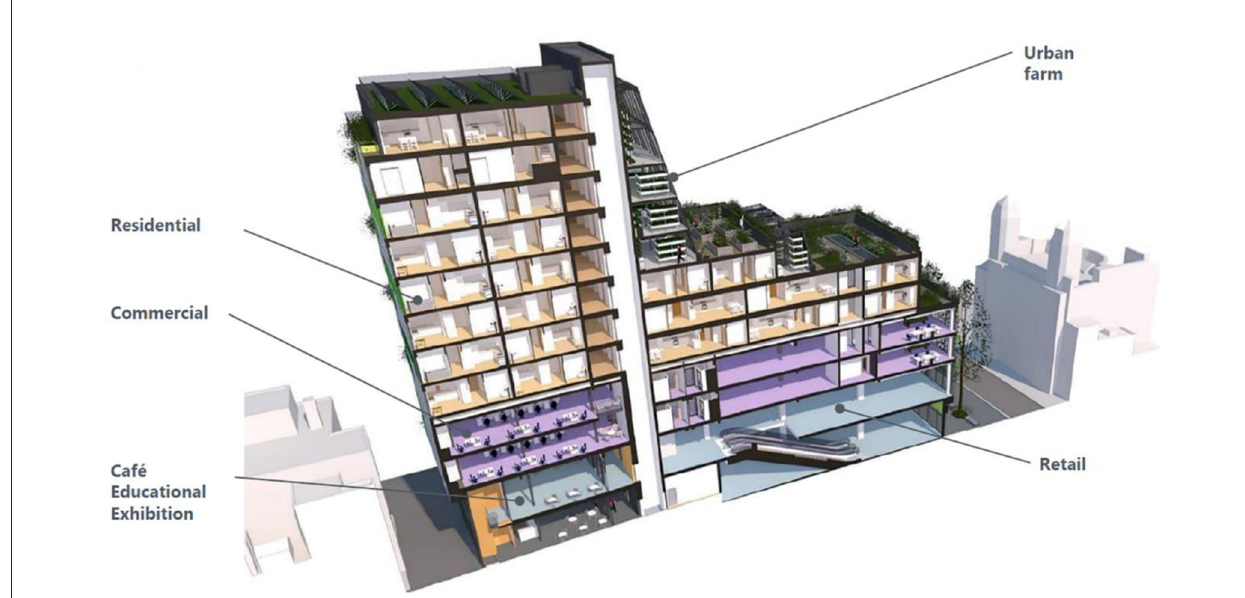
FIGURE1 Mixed use of proposed development. Image used in focus group presentations and reproduced with kind permission from the architects.